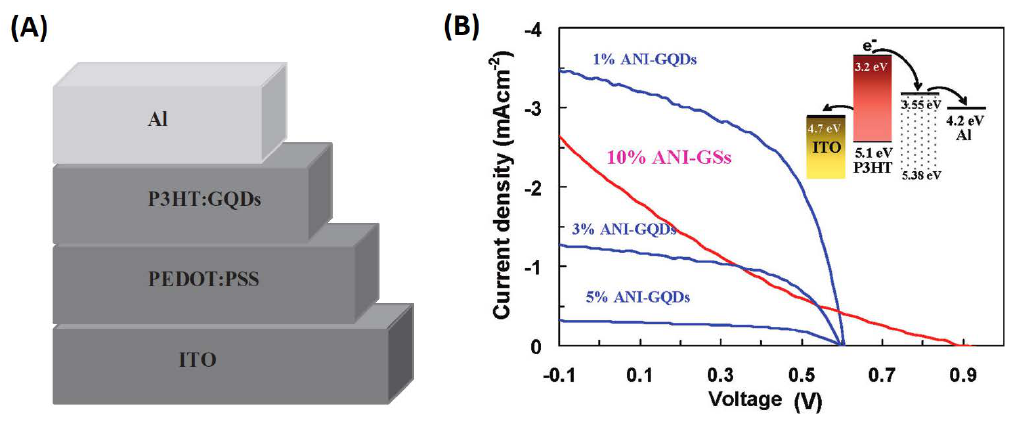
Figure 7. ( A ) Schematic representation; and ( B ) J–V curves of ITO/PEDOT:PSS/P3HT:GQDs/Al device based on aniline-modified GQDs with different GQDs content. Reproduced with permission from Ref.